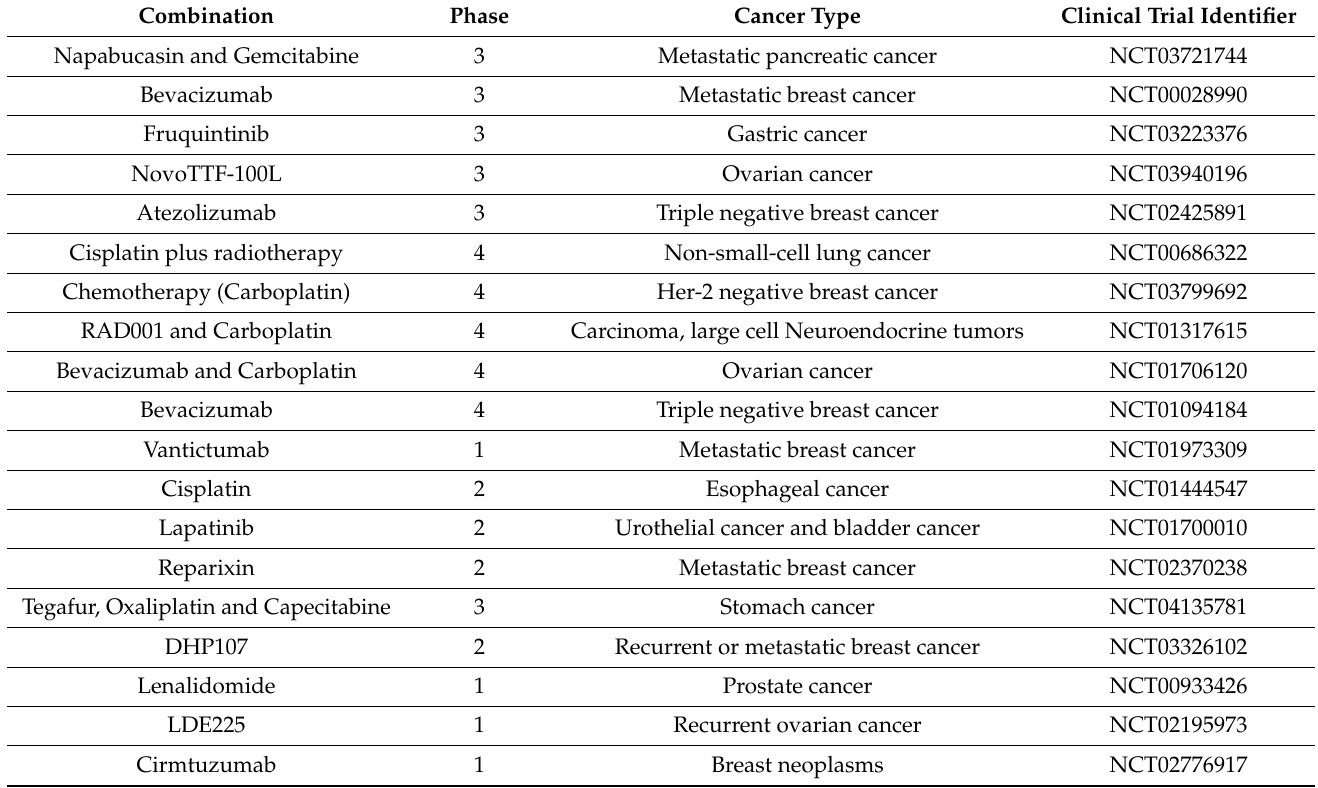
Table 2. Clinical trials involving